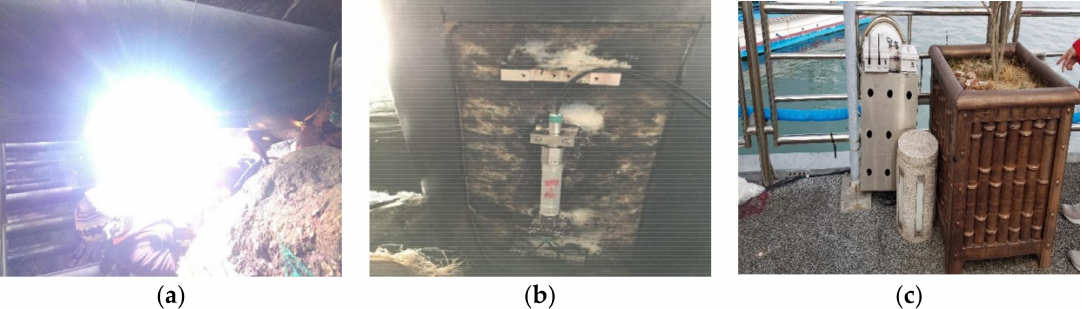
Figure 10. ( a ) Underwater welding of the FBG strain sensor; ( b ) installed FBG strain sensors on the pile; and ( c ) gateway in the secured case installed on the port structure.